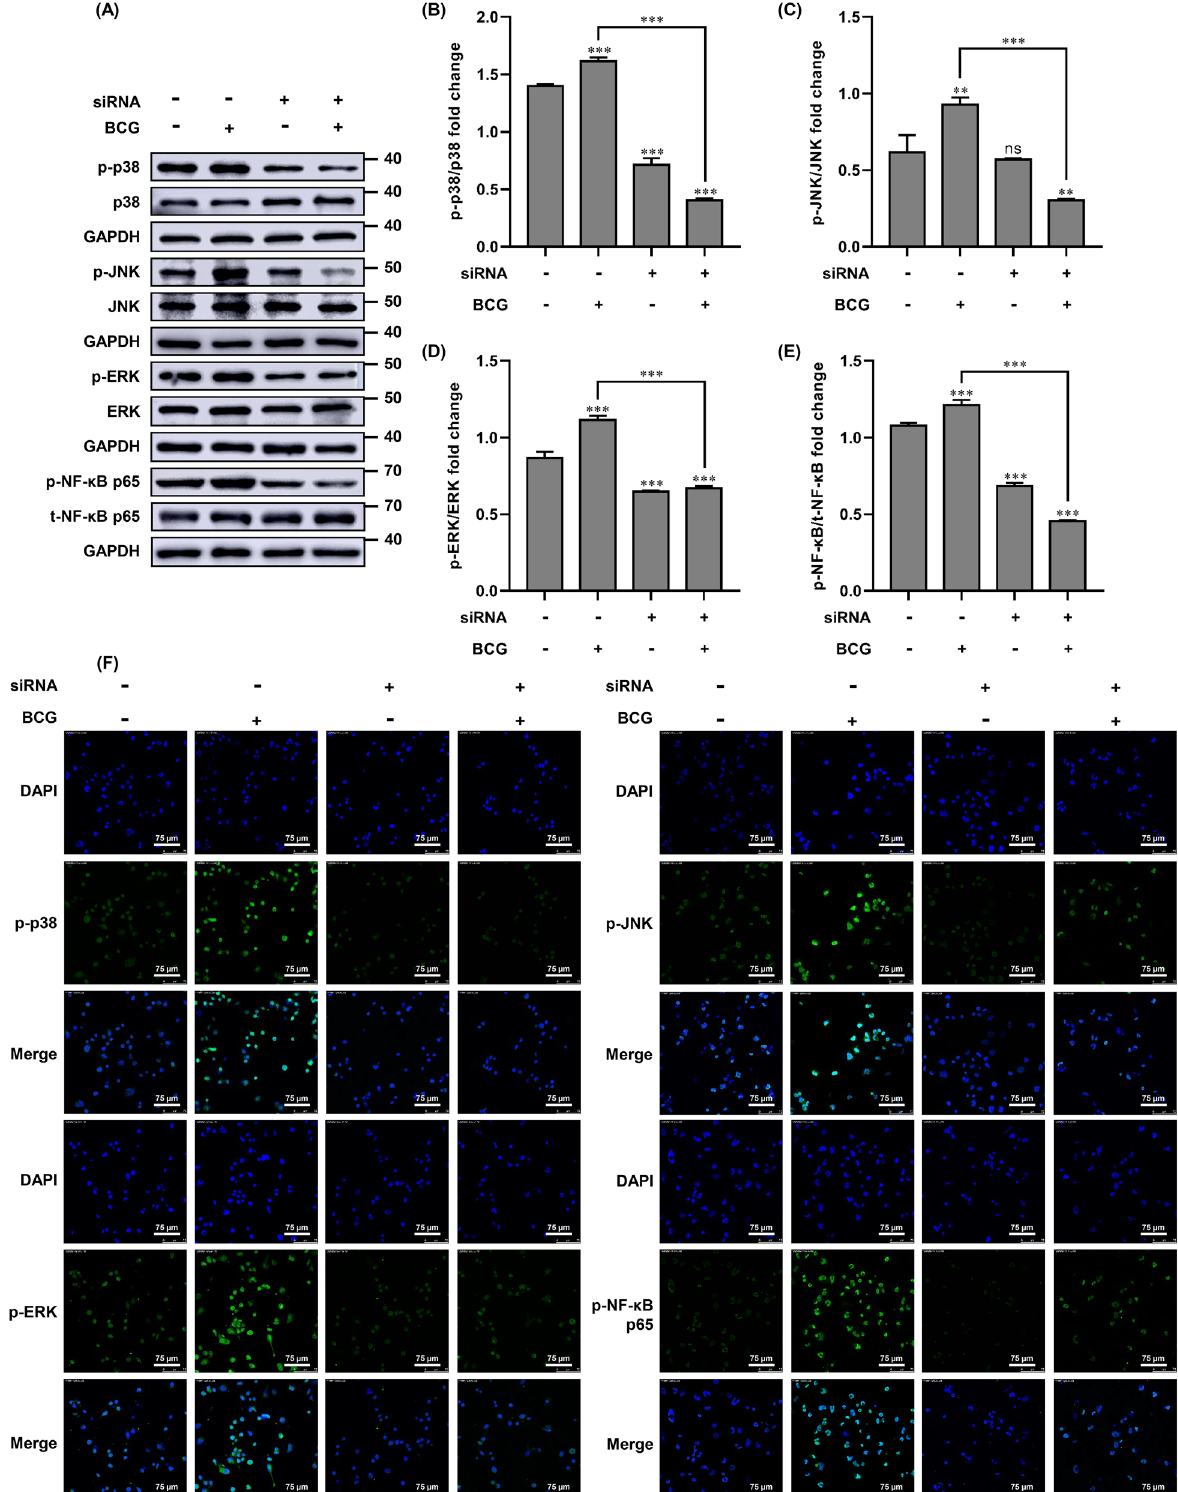
Figure 5. Effect of DUSP1 knockdown on MAPKs/NF-κB signaling pathway induced by BCG infection. ( A ) THP-1 cells were transfected with siRNA-NC (negative control) or siRNA-DUSP1 for 24 h, and then infected with BCG and cultured for 6 h. The expression of p-p38, p38, p-ERK, ERK, p-JNK, JNK, p-NF-κB p65 and t-NF-κB p65 were detected by Western blotting. ( B – E ) MAPKs/NF-κB signaling pathway results of grayscale analysis of key protein expression. ( F ) THP-1 cells were transfected with siRNA-NC (negative control) or siRNA-DUSP1 for 24 h, and then infected with BCG and cultured for 6 h. The expression levels of p-p38, p-ERK, p-JNK and p-NF-κB p65 were detected by immunofluorescence. Scale bar, 75 μm. All data are represented as mean ± SD (n = 3). (* p < 0.05, ** p < 0.01, *** p <